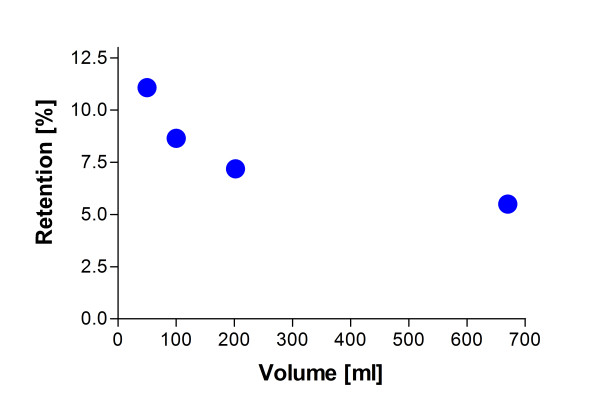
Elution of retained liposomes by the buffer flow. Liposomes labeled with rhod-PE were chromatographied on 8 mL G25M. TX-100 was added after different extensive washing volumes to estimate the slow elution due to shearing forces of the buffer flow.